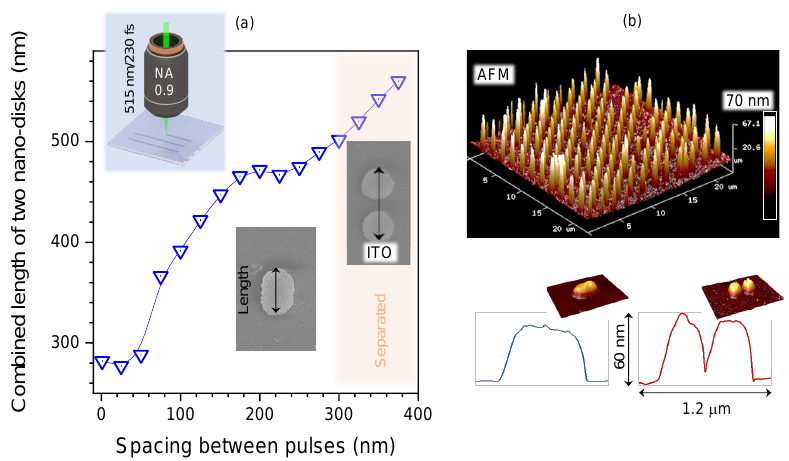
Figure 2. ( a ) Plot showing the length of two pulse-burst-exposed ITO nano-disks vs. separation between these two bursts S p measured via SEM imaging. ( b ) AFM profilometry of laser-printed nano-disks. Two pulse-burst exposure of ITO film after wet etching in HF solution. Polarisation of laser E-field was horizontal, NA = 0.9, pulse energy E p = 0.92 ± 0.02 nJ (on sample), N = 10 pulse bursts per disk at f = 5 kHz (for the two-spot exposures).